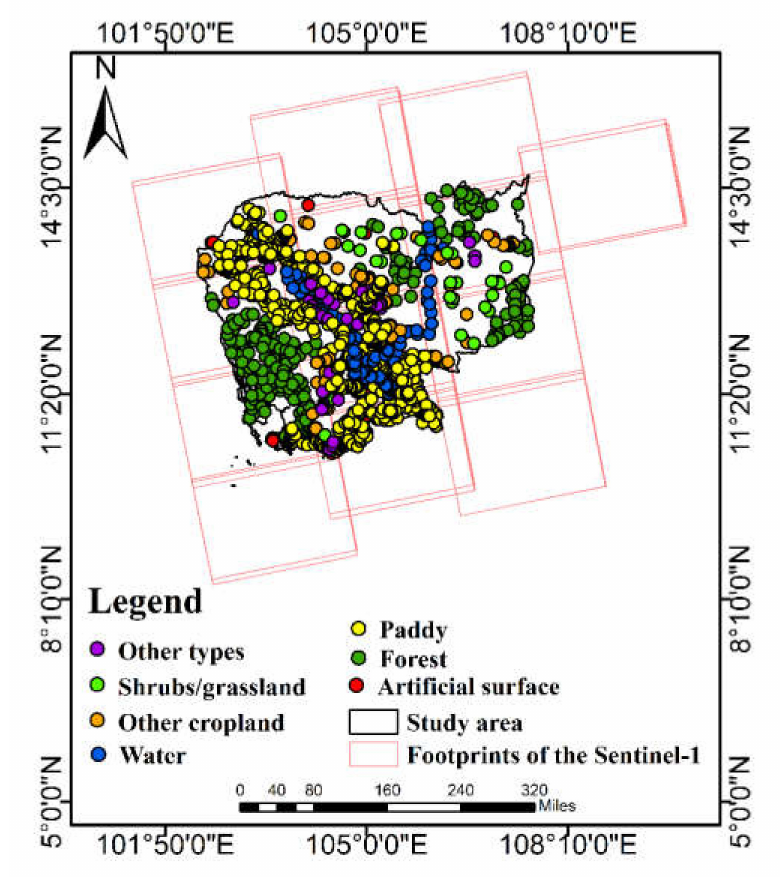
Figure 6. Spatial distribution of training samples. Table 3. Statistics of the number of training